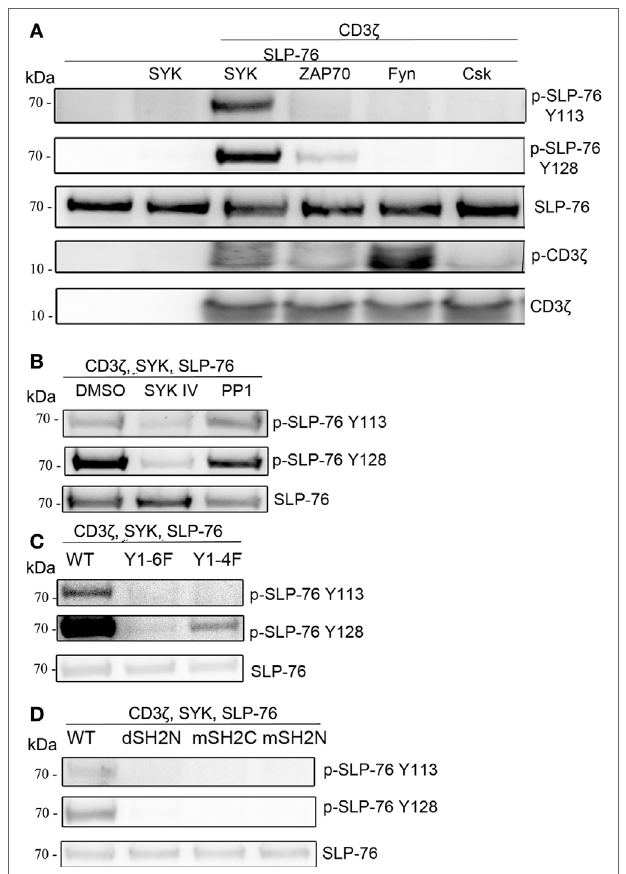
FigUre 3 | ITAM and SYK-dependent, but Src-independent SLP-76 phosphorylation. S2-cells were co-transfected with the indicated proteins. Equal numbers of FACS-enriched GFP + cells were analyzed by western blot. (a) Analysis of SLP-76 and CD3 ζ phosphorylation upon co-expression with SYK, ZAP70, Fyn, or Csk. (B) S2-cells were co-transfected with GFP, SLP-76, CD3 ζ , and SYK. SLP-76 phosphorylation was analyzed in GFP + cells upon treatment with the SYK-family kinase inhibitor SKY IV, the Src-family kinase inhibitor PP1 or DMSO as a carrier control. (c) Analysis of SLP-76 phosphorylation upon co-expression of GFP, SLP-76, SYK, and either wild-type (wt) CD3 ζ or the indicated CD3 ζ ITAM-mutants. (D) Analysis of SLP-76 phosphorylation upon co-expression of GFP, SLP-76, CD3 ζ and either wild-type (wt) SYK or the indicated SYK SH2 domain mutants. All western blots are representative of at least three independent